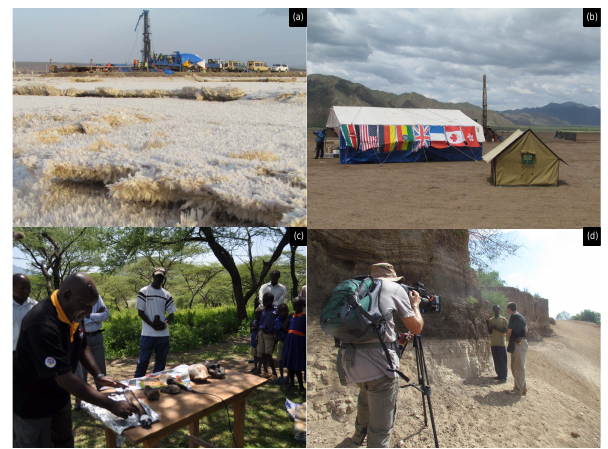
Figure 2. HSPDP drilling operations: (a) Oso Isi drill site (NAO14) in the Northern Awash area, northern Ethiopia (photo C. Camp- isano); (b) West Turkana (WTK13) drill site, with Lake Turkana and North Island in the background (photo A. Cohen); (c) West Turkana drill site (photo A. Noren); (d) Koora Plain/Olorgesailie (OLO12- 1A drill site with Mt. Olorgesailie in the background (photo R. Dommain).